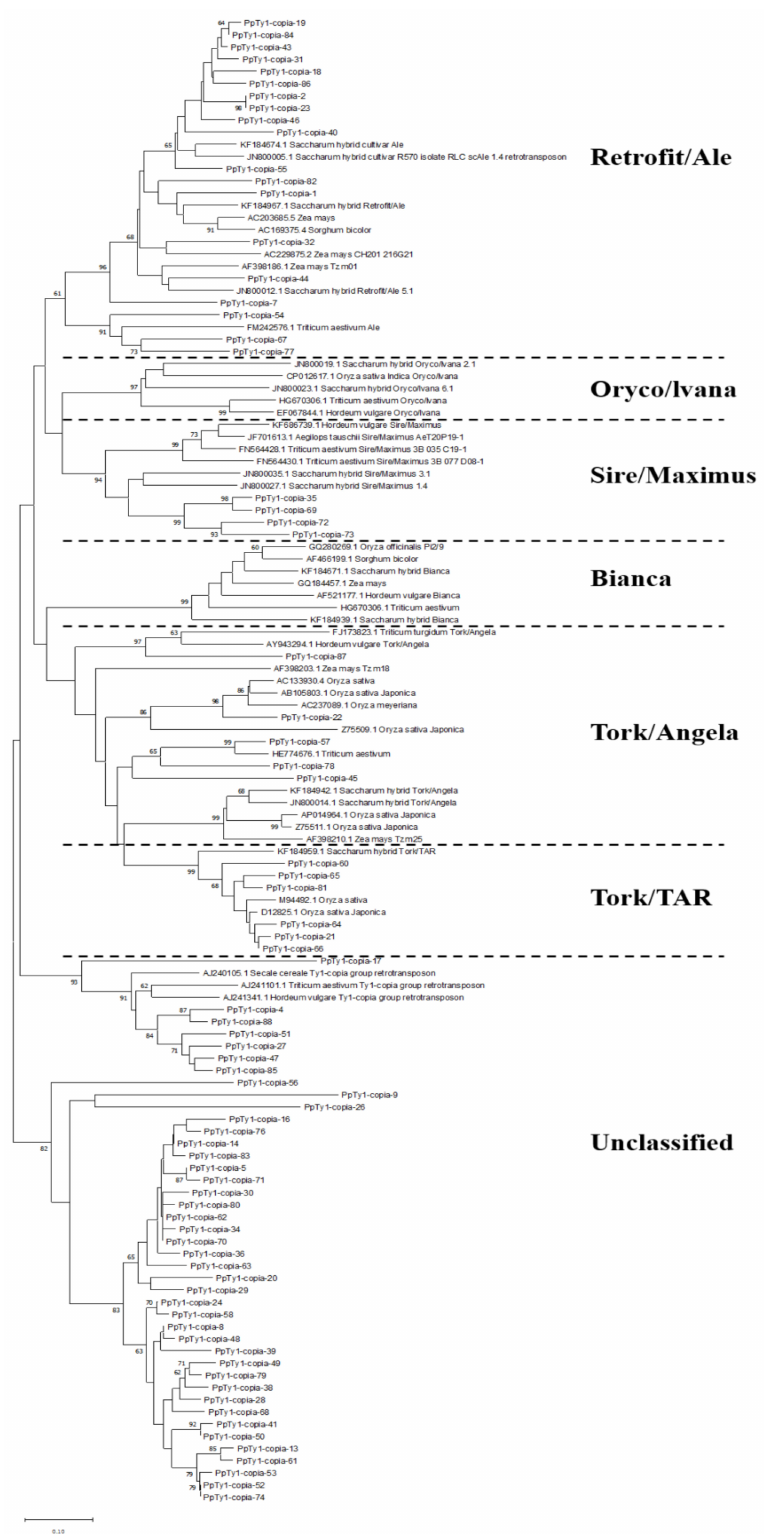
Figure 2. Phylogenetic analysis of amino acid sequences based on Ty1- copia RT sequences from P. purpureum . The RT sequences of Saccharum , Oryza , Hordeum , Sorghum , Triticum , and Zea were used for comparative phylogenetic analysis. Bootstrap values over 60 are indicated at the